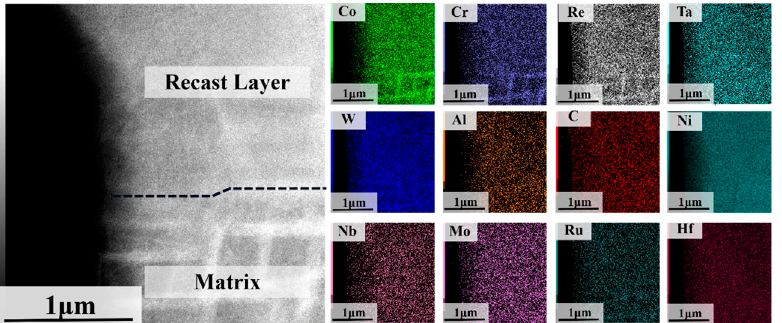
Figure 4. Energy dispersive spectroscopy area scanning profiles of the recast layer and matrix tran-